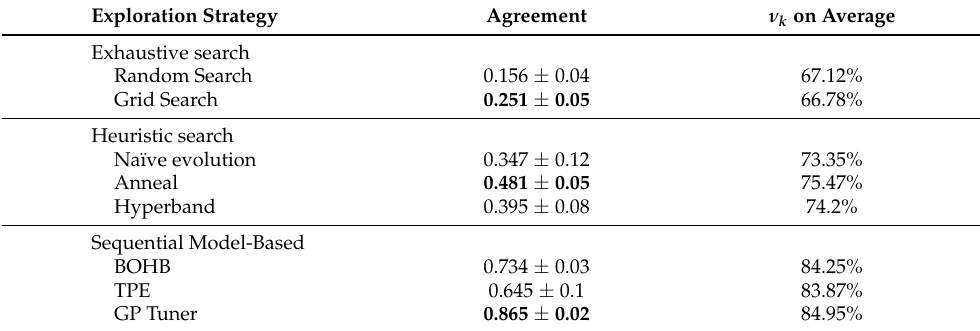
Table 3. Level of agreement between privileged information (or knowledge) derived from the surrogate model and human expertise by using different space exploration strategies. The level of agreement with the human expertise-based model (HExp) is measured using Cohen’s kappa coefficient [117]. The partial recognition performances ν k obtained while exploring the space are averaged and illustrated. From